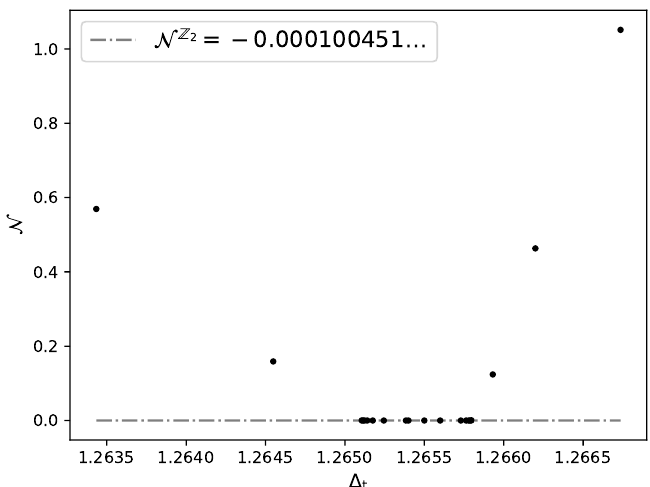
Figure 16: Dependence of the navigator function on ∆ ( ∆ ∆ ) = ( 0.518139... ,1.41252... ) . The navigator function is constant in a small φ , s region, and equal in that region to the navigator function for the case of a mixed- correlator Ising setup where identical assumptions were made on the equivalent sec- − odd , S ←→ (cid:90) − tors ( V ←→ (cid:90) 2 2